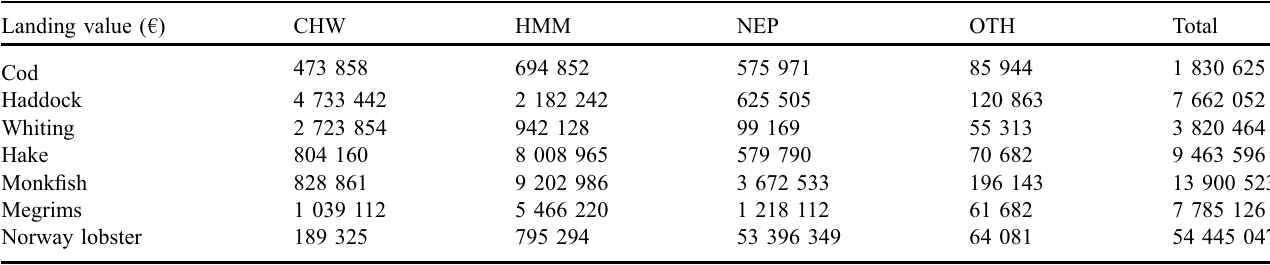
Table A.3. Total landing value (Euros) by the polyvalent general fl eet segment þ 18 m of the main species within each fi shery (cod, haddock,